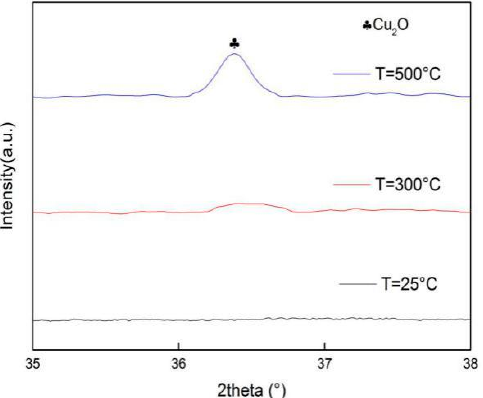
Figure 4. Figure 3 locally enlarged graphs in the range of 2 θ from 35° to 38°.